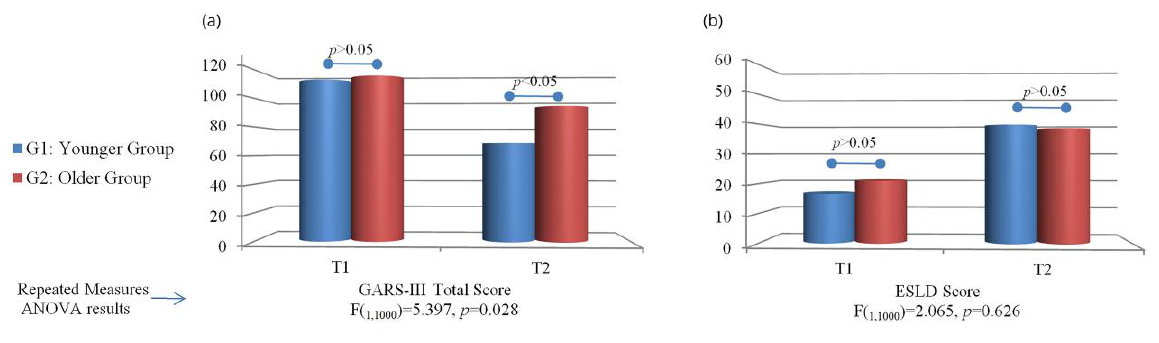
Figure 2. Average scores on ( a ) GARS-III and ( b ) ESLD for G1 and G2 at two time points and repeated measures ANOVA results.